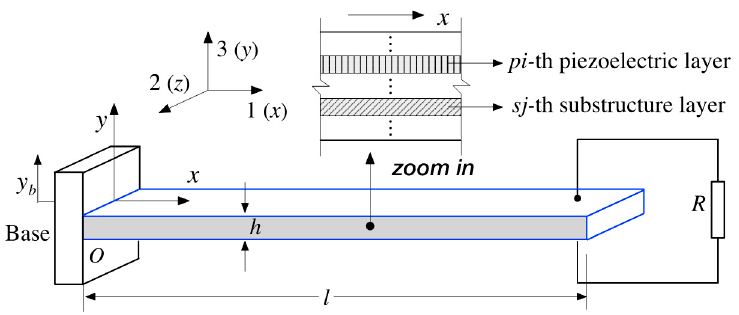
Figure 11. Schematic diagram of the universal composite-laminated piezoelectric cantilever har-